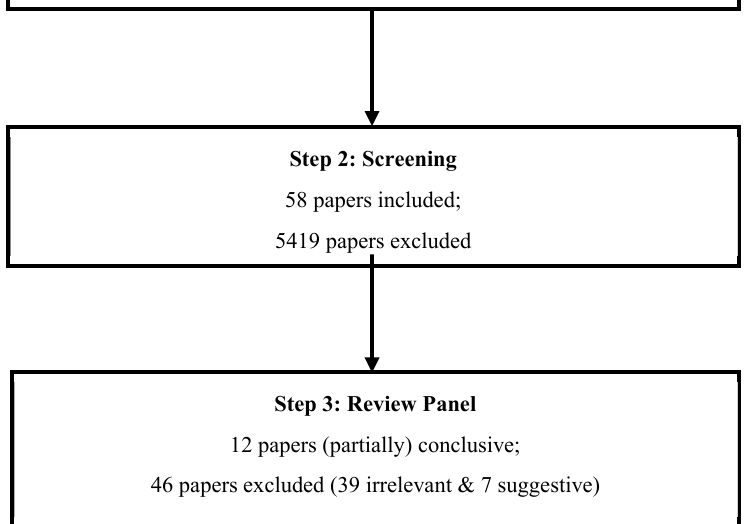
Figure 1. Flowchart of the literature review.